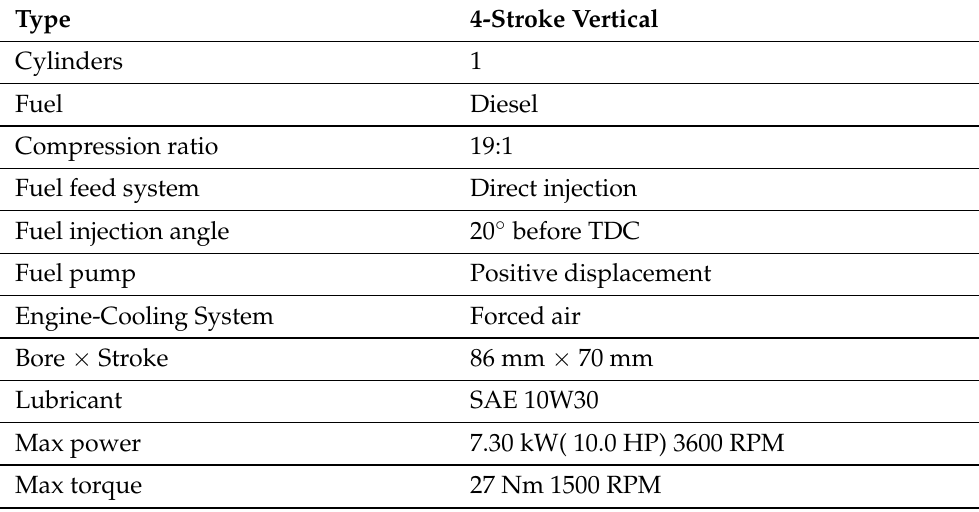
Table 1. CHANGFA 186F engine features.